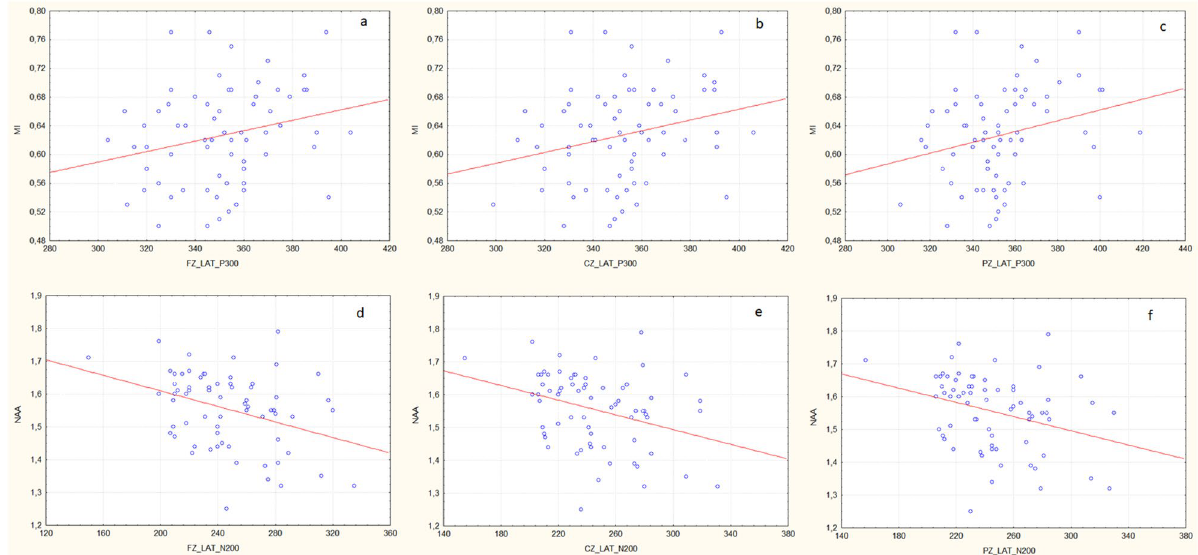
Figure 5. (a–f) Correlations of ERP and MRS measurements in the posterior cingulate gyrus (PCG) region. (a) A significantly positive correlation between mI/Cr ratio and P300 Fz latency (r = 0.224, p = 0.045). (b) A significantly positive correlation between mI/Cr ratio and P300 Cz latency (r = 0.225, p = 0.035). (c) A significantly positive correlation between mI/Cr and P300 Pz latency (r = 0.252, p = 0.038). (d) A significantly negative correlation between NAA/Cr ratio and N200 Fz latency (r = -0.358, p = 0.003). (e) A significantly negative correlation between NAA/Cr ratio and N200 Cz latency (r = − 0.329, p = 0.006). (f) A significantly negative correlation between NAA/Cr ratio and N200 Pz latency (r = − 0.311, p = 0.01). Fz frontal region, Cz central region, Pz parietal region, NAA N -acetylaspartate, Cr creatine, mI